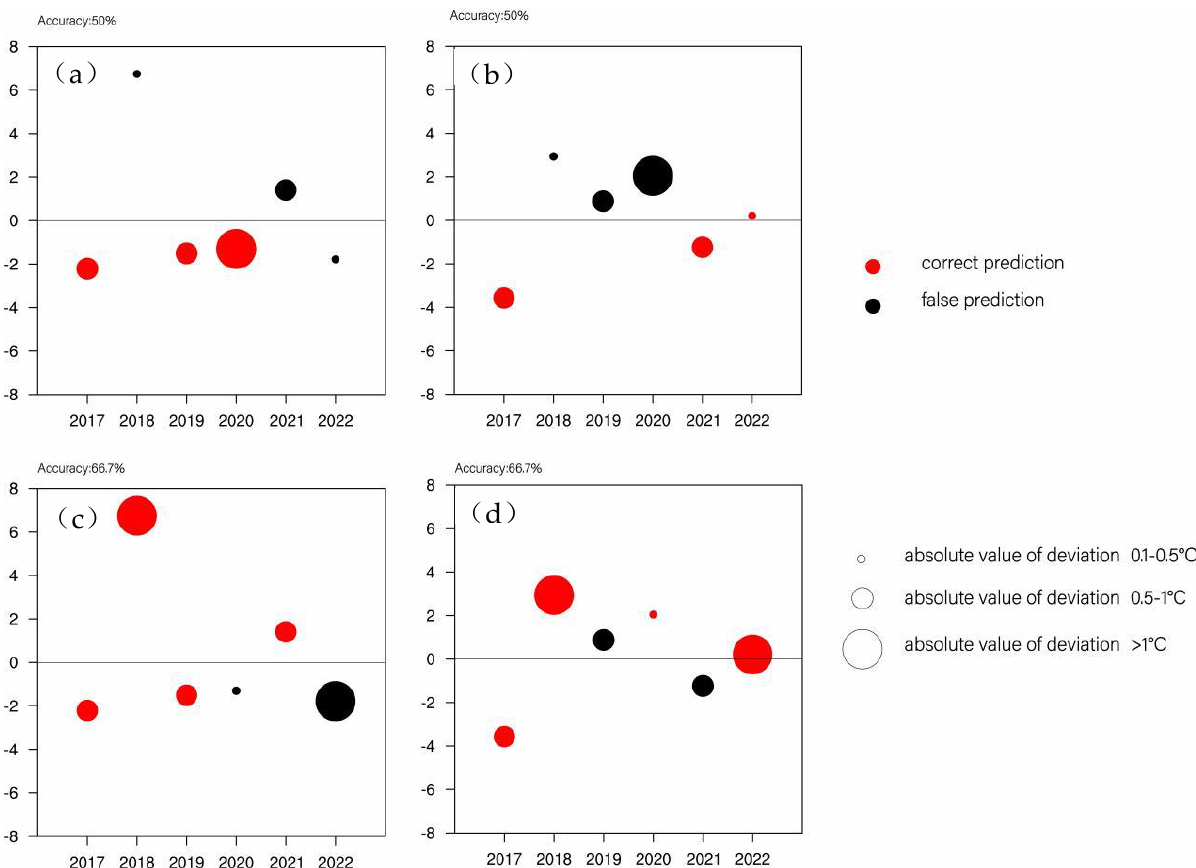
Figure 9. Forecast accuracy of southerly wind over Northeast China in ( a ) July and ( b ) August using the China offshore SST.